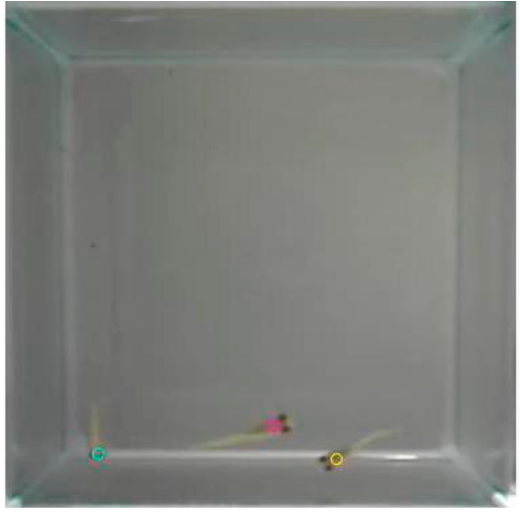
Figure 7. The capture of the new video with marked “O” on the coordinates.